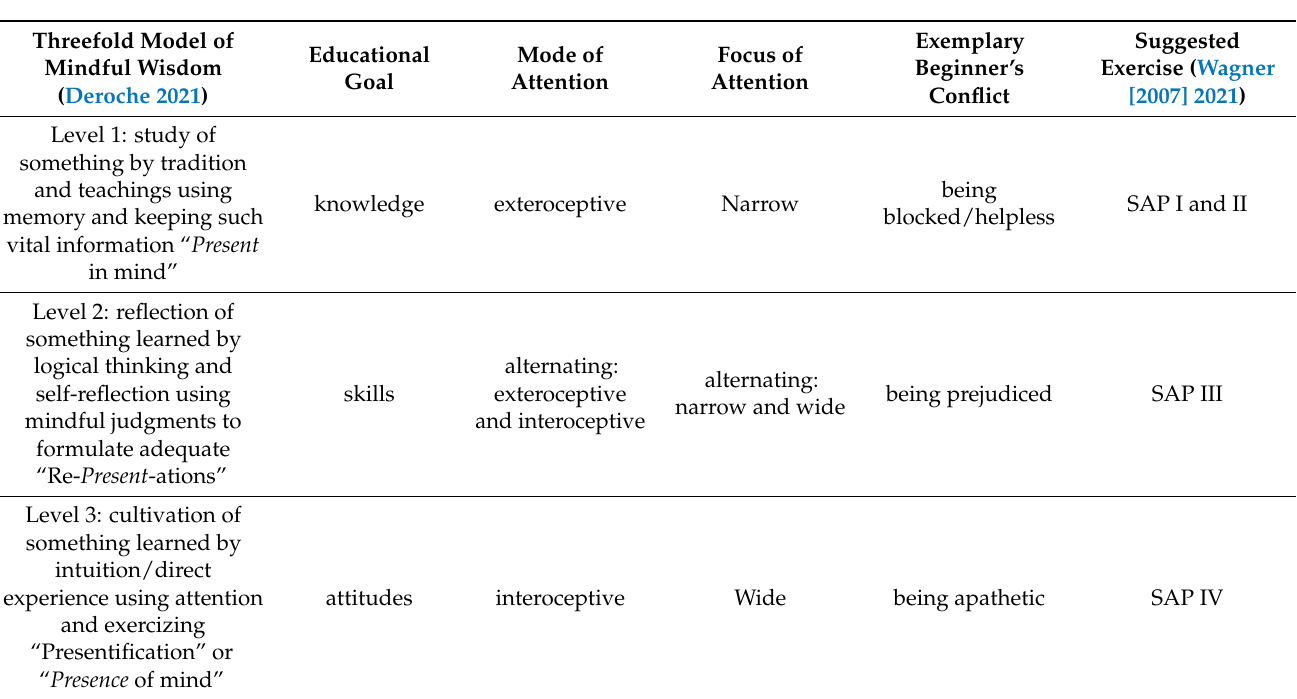
Table 2. An extended and integrated framework of the “Threefold model of mindful wisdom” (summarized according to Deroche (2021)), including educational goals, modes of attention, and foci of attention as elements needed for the analysis and resolution of beginner’s conflicts with the aid of the “Theory of mental interference” and the “Stated attentive perception” (both according to Wagner [2007]